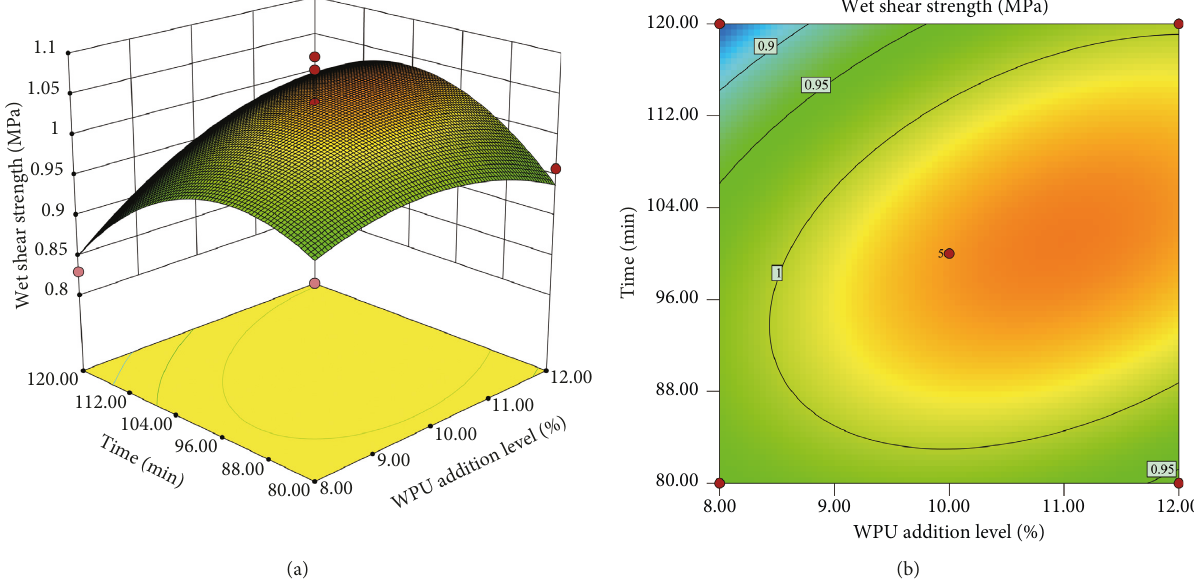
Figure 6: Response surface and contour plots for effect of time and WPU addition level on wet shear